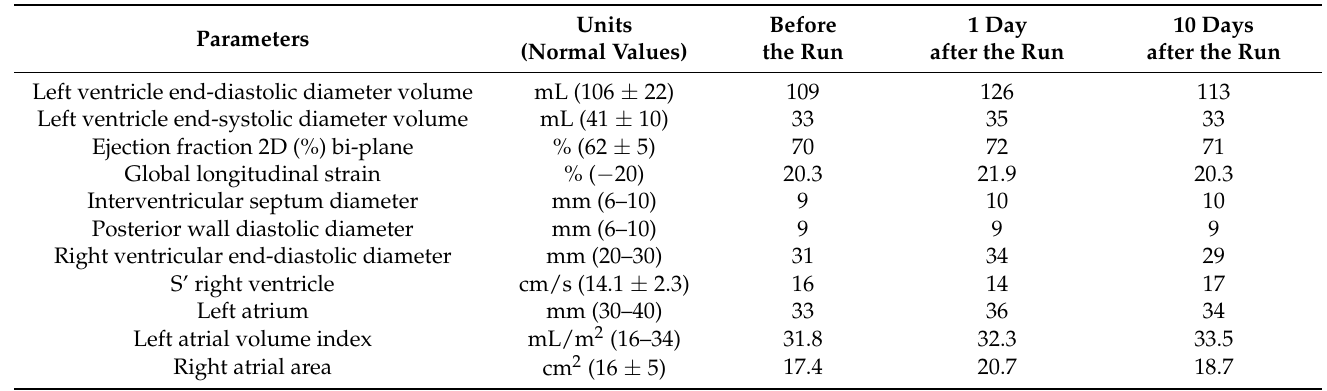
Table 8. Heart systolic function in echocardiographic